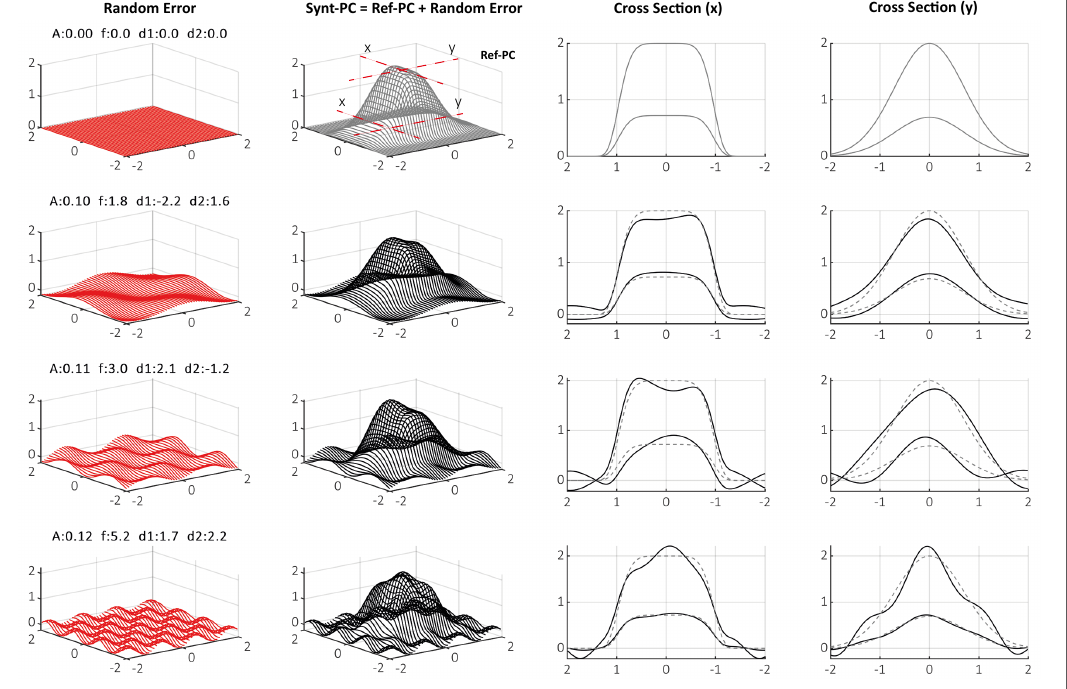
Figure 2. Functions developed to create the Synthetic Point Clouds (Synt-PC) First row: Function without error, representing the reference PC (Ref-PC) (Equation (1)). Rows (2 to 4): Synthetic functions created with errors based on random parameters (Equation (2)). Columns (left to right): Error function; sum of Ref-PC + Error function, X cross-section, Y cross-section. Dotted lines correspond to the Ref-PC and continuous lines to the